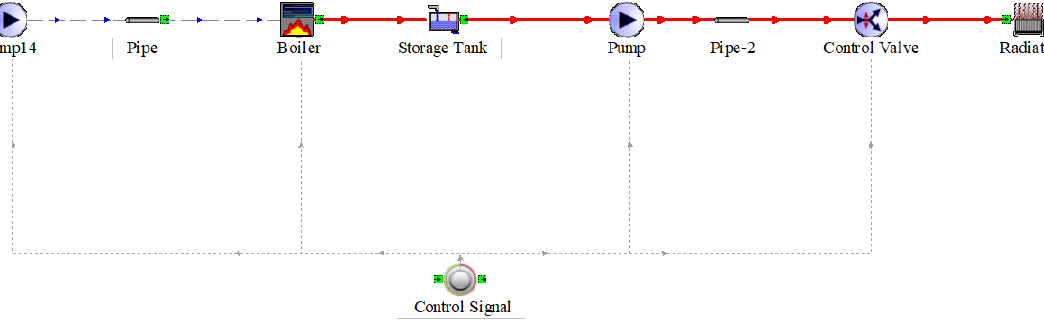
Figure 5. Expanded TRNSYS Model macro.